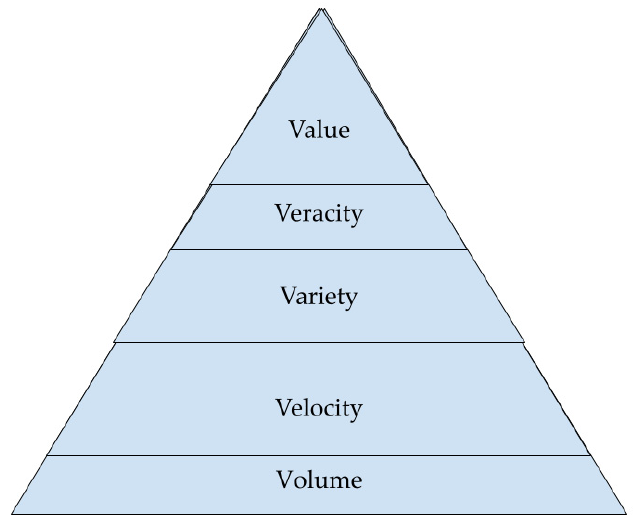
Figure 4. Overall dimensions of Big Data.